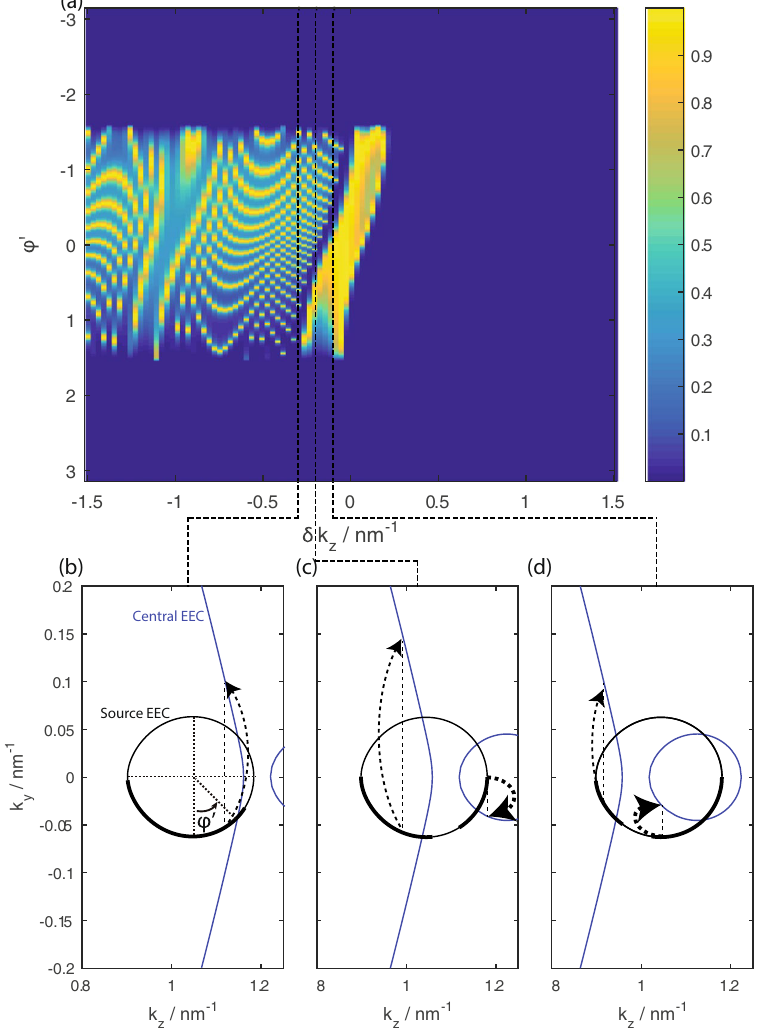
Figure 7. ( a ) The transmission as a function of the source angular coordinate ϕ ′ , and the central segment k z shift δ k z at E 2 = 60 meV. ( b ) to ( d ) show the source (black) and central segment (blue) EECs at the δ k z values indicated on the plot. The states on the source EEC propagating in the + y direction with ranges of k z that overlap with the k z range of states on the central segment propagating in the + y direction are indicated as thicker lines. Note the narrow ϕ ′ ranges in ( c ) and ( d ) where part of the source EEC falls into the gap between the central segment bulk and Fermi arc states. The thickness of the arrows pointing from the source to the central segment EECs in ( b ) to ( d ) show the relative probability of transmission form the source states to the central segment states at the value of k z indicated by the dotted